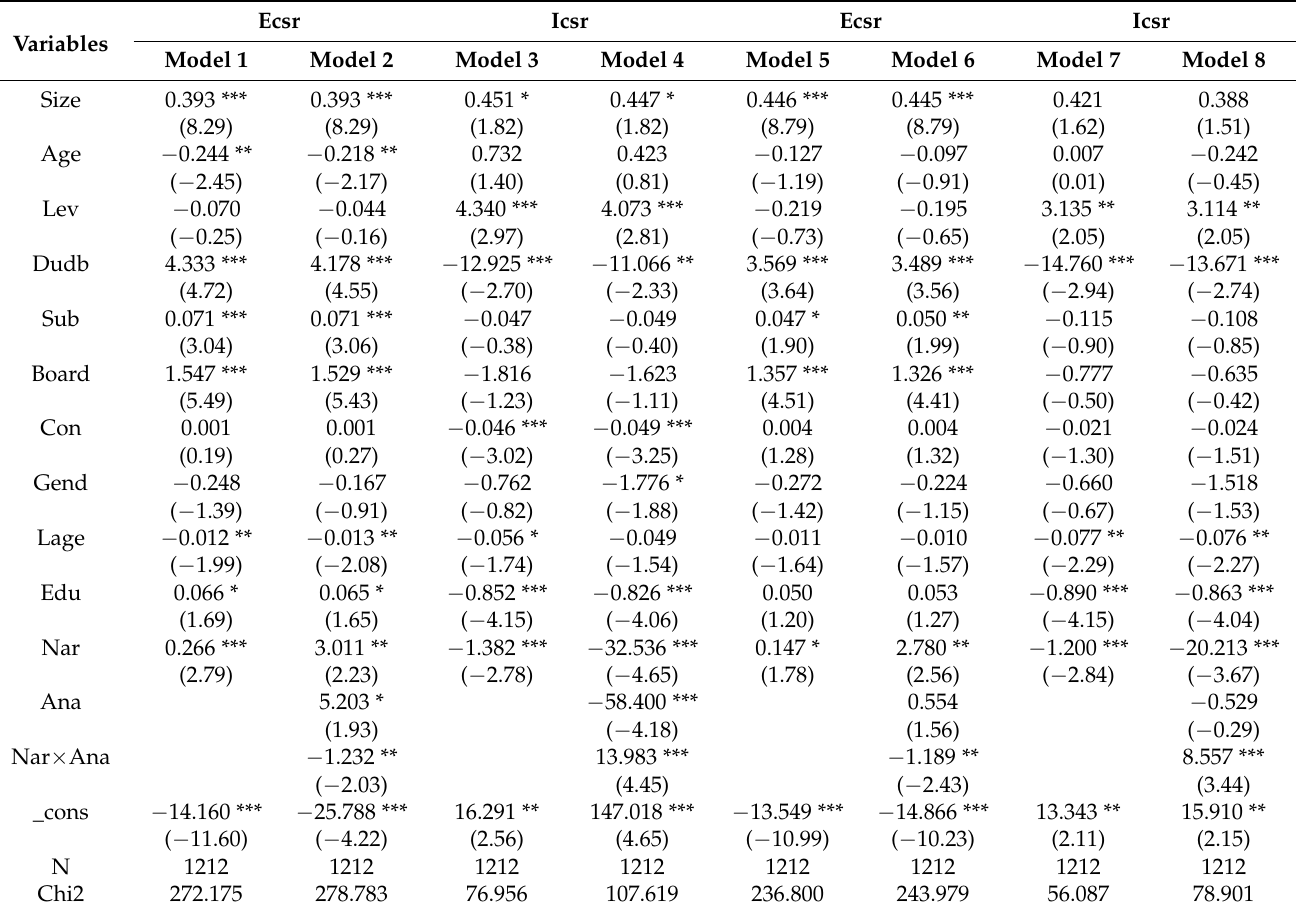
Table 5. Robustness